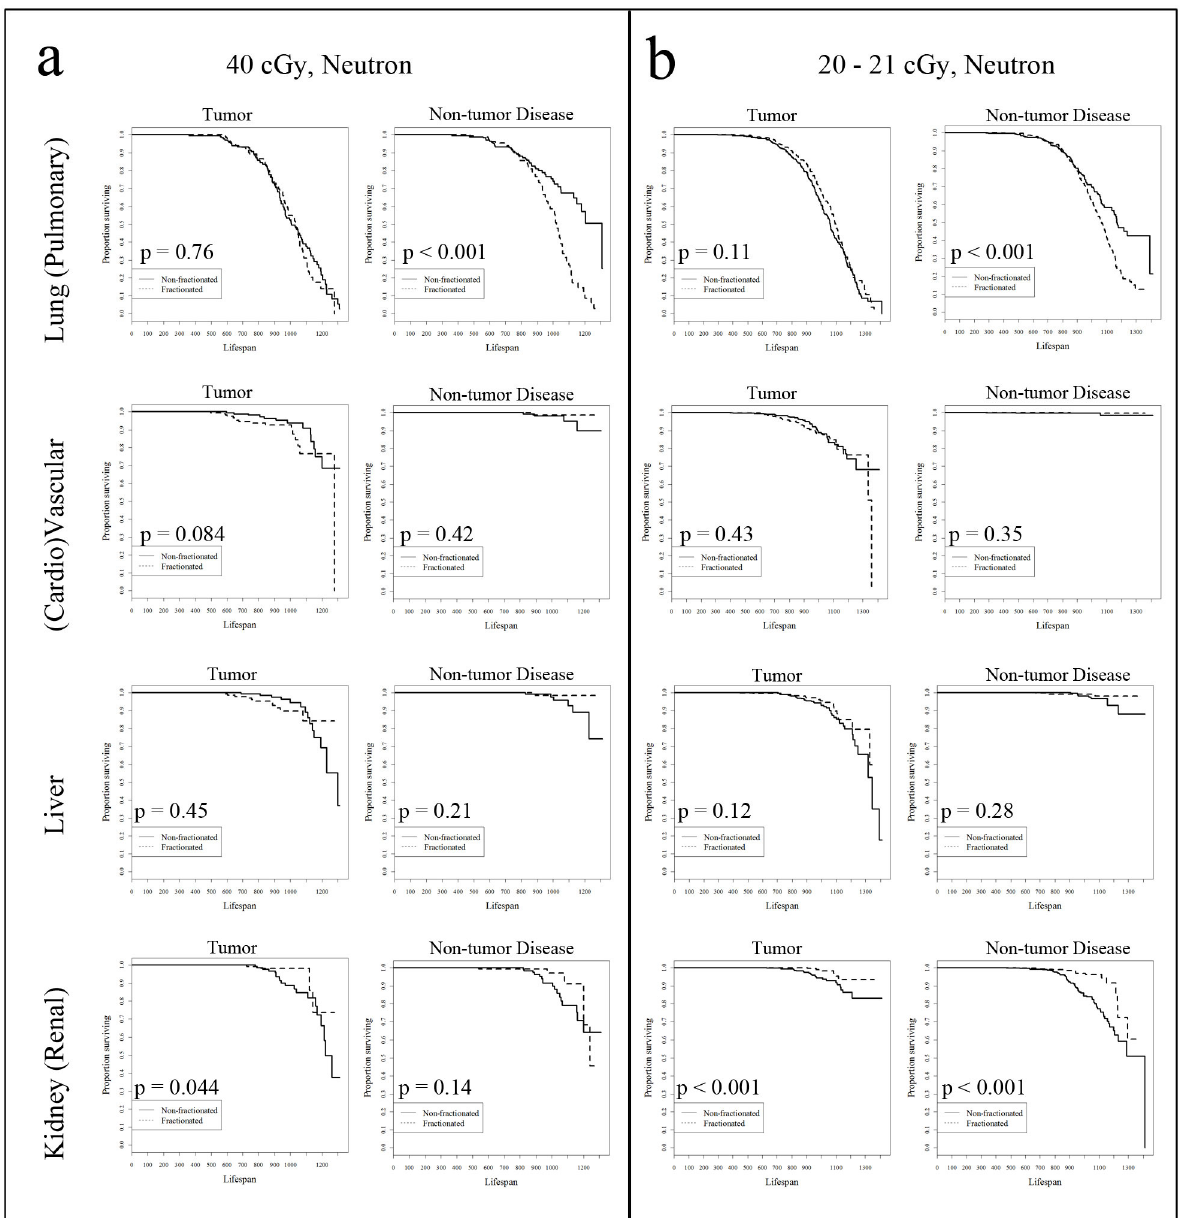
Figure 2. Neutron radiation survival